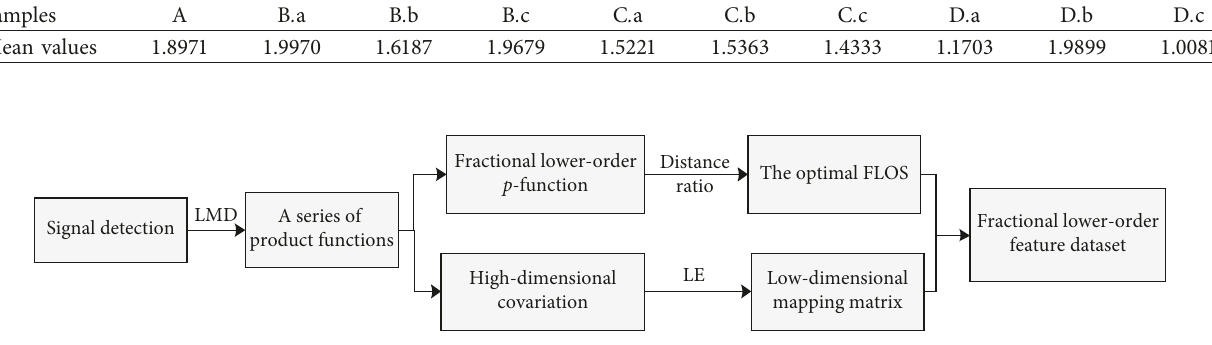
Figure 4: Fractional lower-order feature extraction